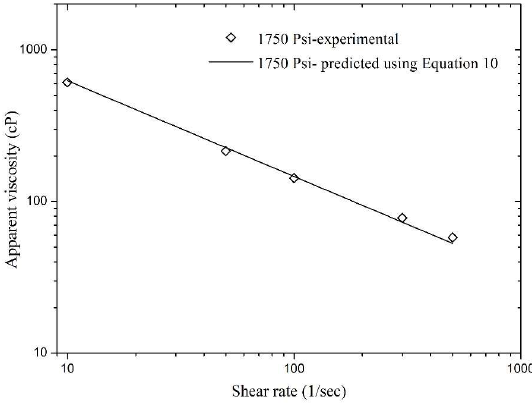
Figure 9. Validation of Equation (10).